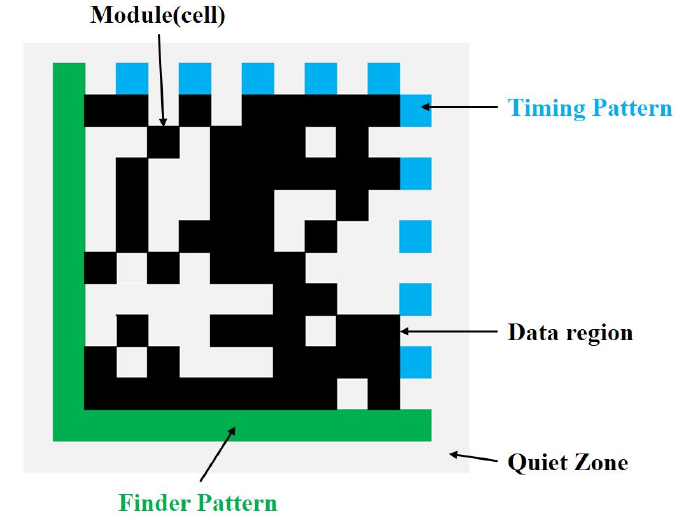
Figure 2. The structure of the DM